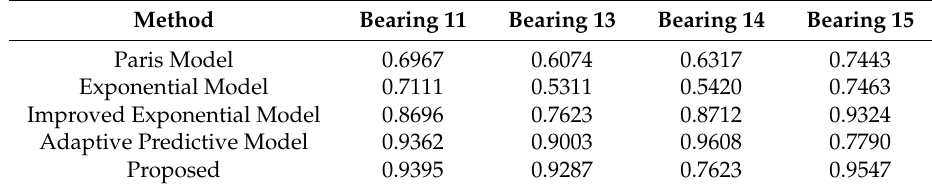
Table 4. The CRA Scores obtained using the Proposed HI and other RUL estimation